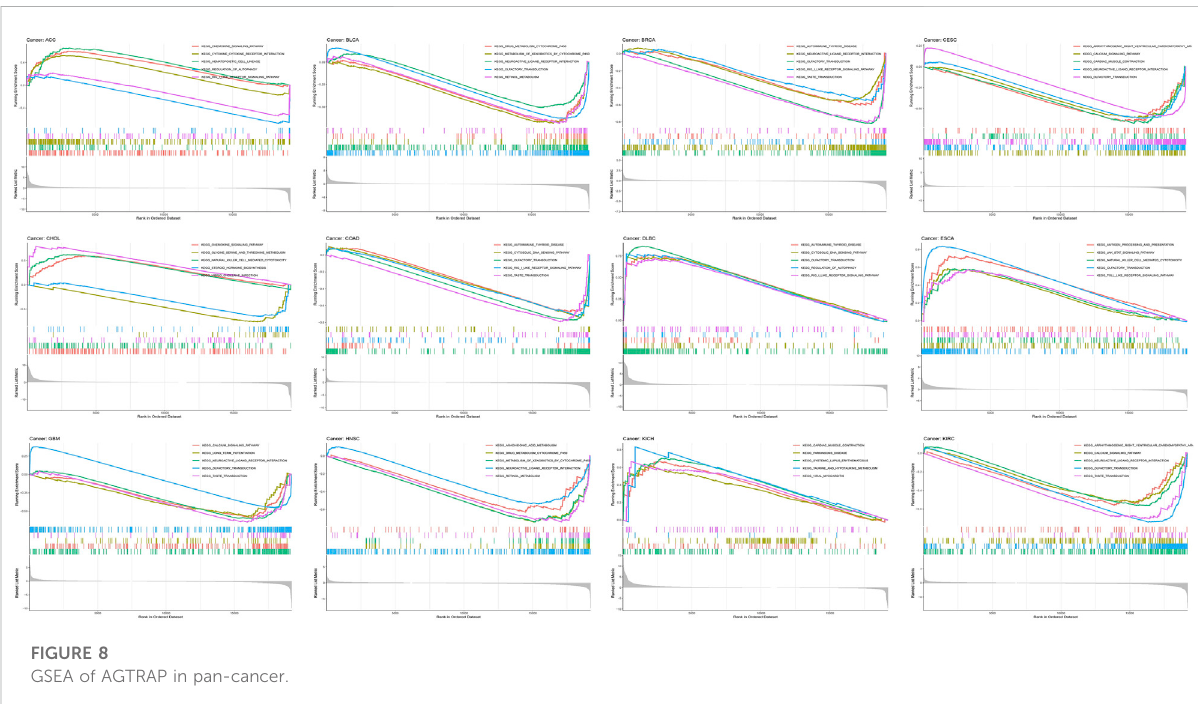
FIGURE 8 GSEA of AGTRAP in